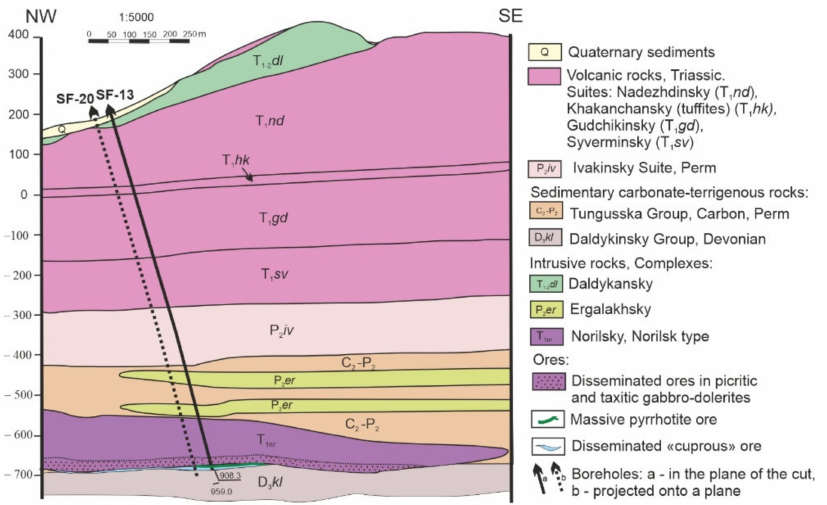
Figure 2. Geological cross-section of the Talnakh intrusion (northwestern branch) showing the position of the SF-13 and SF-20